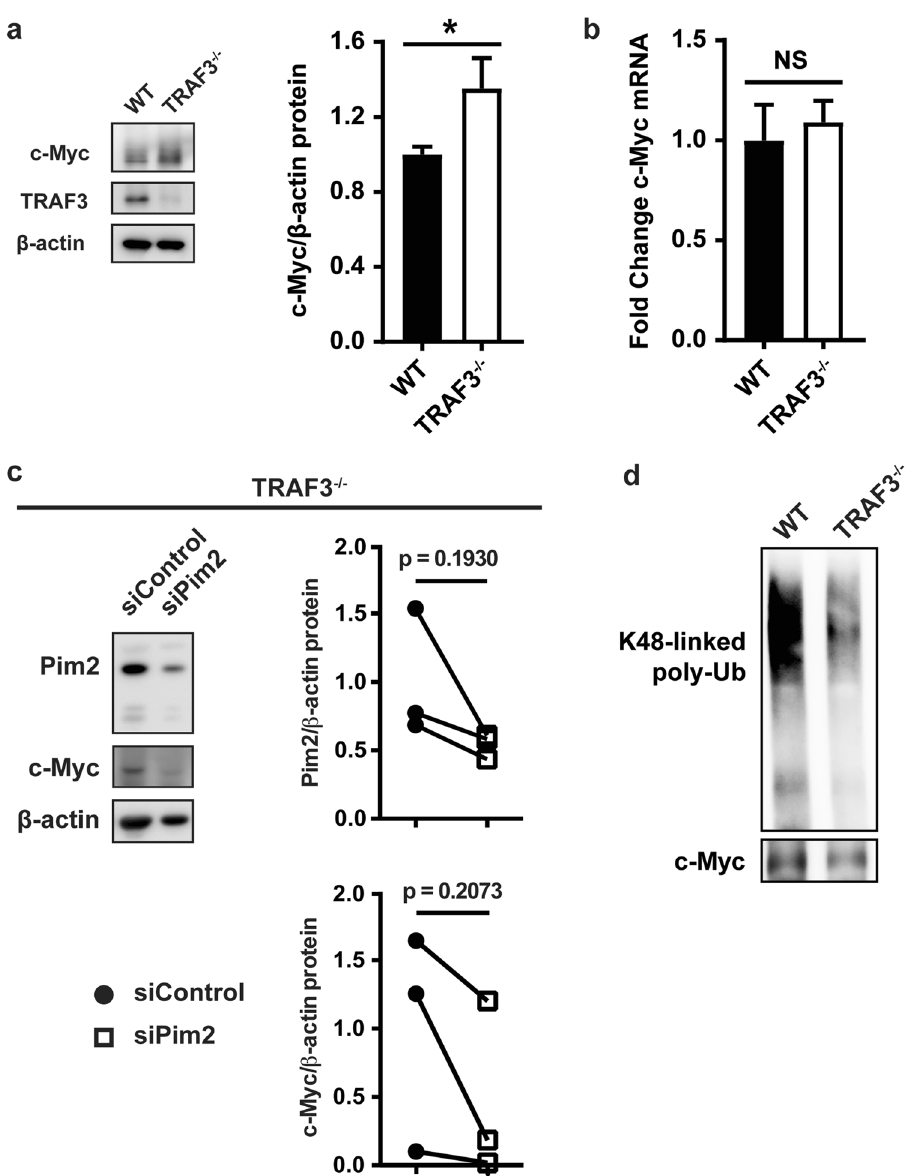
Figure 3. Pim2 regulation of c-Myc stability in the absence of TRAF3. ( a ) WCLs of WT and TRAF3 − / − B cells were analyzed with WB for c-Myc expression. Graph depicts mean values ± SEM (N = 11 from 3 independent experiments). An unpaired t test was used to evaluate differences for statistical significance ( * p < 0.05). ( b ) c-Myc mRNA levels in WT and TRAF3 − / − B cells were assayed with RT-PCR. Data were normalized to GAPDH and fold change was determined using the comparative Ct method. Graph represents mean values ± SEM shown (N = 3 mice). Student’s t test was used to evaluate differences for statistical significance. (NS = not significant). ( c ) TRAF3 − / − B cells were transfected with siRNA scrambled control or siRNA targeting Pim2. 24 hrs later, Pim2 and c-Myc expression in WCLs were analyzed with WB. Graphs depict Pim2 or c-Myc expression/ β -actin loading control and normalized to the siRNA control. A paired t test was used to evaluate differences for statistical significance (N = 3). ( d ) Following immunoprecipitation of c-Myc from WT and TRAF3 − / − B cells, K48-linked polyubiquitination was assayed with WB. Blot is representative of 3 independent experiments. ( d ) was previously presented in the doctoral dissertation of N.M 23